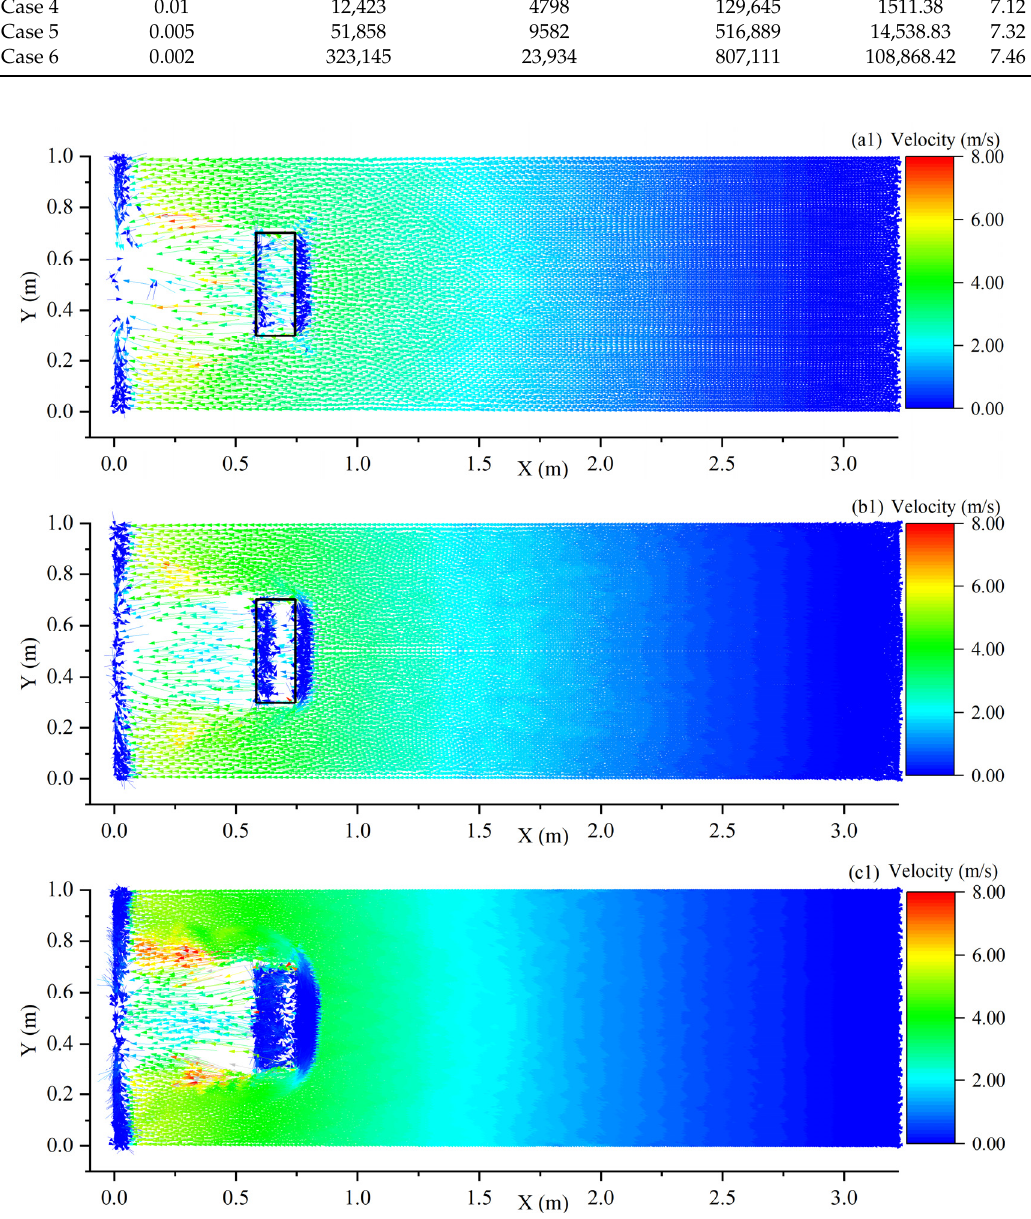
Figure 12. Velocity distribution at 0.74 s for Case 4 ( a1 ), 5 ( b1 ) and 6 ( c1 ) displayed in Table 6.